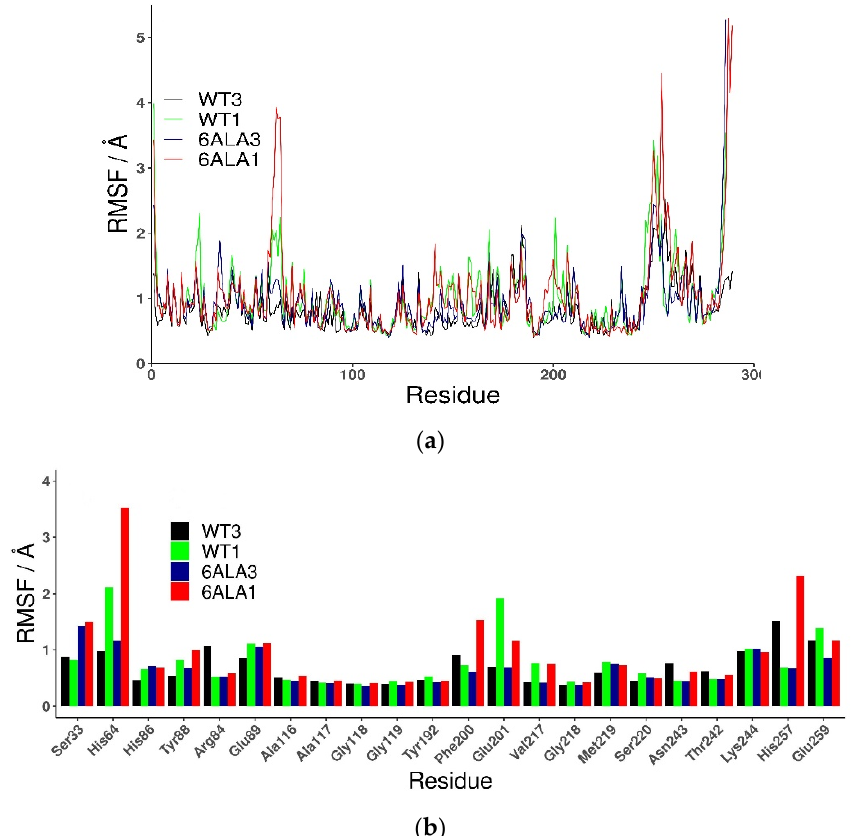
Figure 3. Root mean square fluctuations (RMSF) calculated for the last 50 ns of the simulation of all ( a ) and active site amino acids ( b ), observed in MD simulations for various PNP forms: trimeric WT3 PNP (black); monomeric WT1 PNP (green), trimeric 6Ala3 mutant (blue), and monomeric 6Ala1 mutant